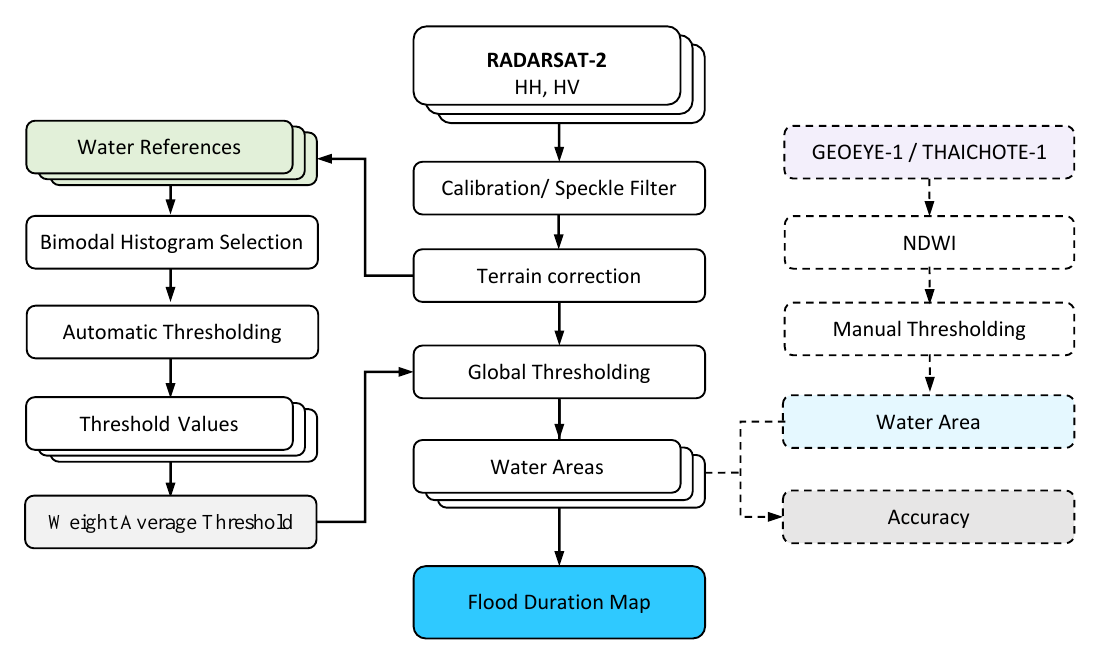
Figure 3. Work flow diagram for automatic flood extraction for RADARSAT-2. The optical image procedure shown by the dashed lines was used for a one-time accuracy assessment.